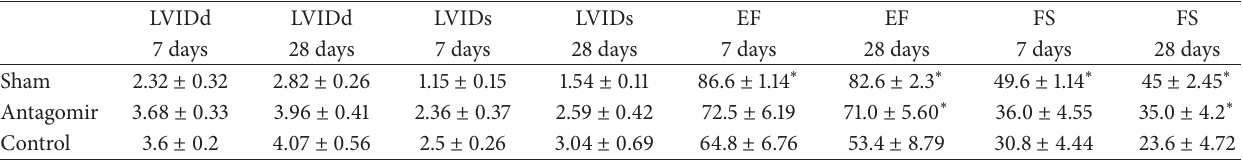
Figure5:miR-208asilencingattenuatescardiomyocytehypertrophyandfibrosisandimprovescardiacfunctionat28daysafterMI( ∗ 𝑝 < 0.05 , ∗∗ 𝑝 < 0.001 ). (a) Representative images of hematoxylin and eosin staining indicate a decrease in cardiomyocyte size in antagomir treated mice at 28 days after MI. Scale bar = 40 𝜇 m. (b) Graph comparing mean cardiomyocyte sizes at 28 days after MI. Antagomir treatment decreased the mean cardiomyocyte size compared to controls ( 𝑛 = 3 per group). (c) Graph showing percentage fibrosis in the noninfarcted area. Antagomir treatment decreased fibrosis in the noninfarcted area compared to controls at 28 days after MI ( 𝑛 = 4 per group). (d) Representative images showing miR-208a antagomir decreased fibrosis in the noninfarcted area at 28 days after MI. (e) Bar graph of peri- infarct fibrosis quantification shows reduction in peri-infarct fibrosis in antagomir treatment group at 28 days after MI ( 𝑛 = 4 per group). (f) miR-208a silencing improved cardiac function as measured by fractional shortening at 28 days after MI ( 𝑛 = 4 per group). (g) Representative echocardiography images showing improved wall motion in antagomir treated group compared to control at day 28 after MI. Table 2: Mean echocardiographic parameters at 7 and 28 days after